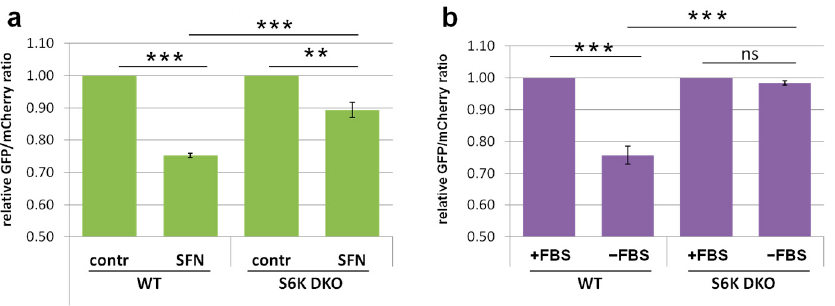
Figure 3. Lack of S6K kinases affects autophagosome-lysosome fusion in cells stressed by SFN exposure or by growth factor deprivation. ( a ) Impact of 20 µM SFN (6 h) or ( b ) growth factor deprivation ( − FBS; 24 h) on GFP/mCherry fluorescence intensity ratio in WT or S6K DKO MEF stably overexpressing GFP-mCherry-LC3, (as described in Materials and Methods). Control cells (contr) were treated with the vehicle (DMSO; a ) or were grown in FBS-supplemented medium ( b ). The experiment was performed in three independent replicates. The data are shown as the mean ± SEM. Statistical significance was determined by one-way ANOVA followed by Bonferroni’s multiple comparison test: ** p < 0.01, *** p < 0.001; ns, not significant.